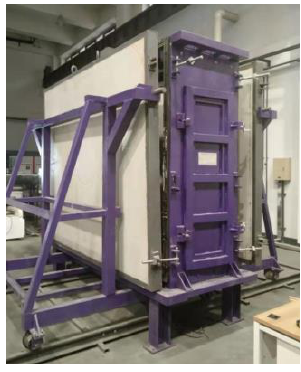
Figure 1. Wind pressure chamber.